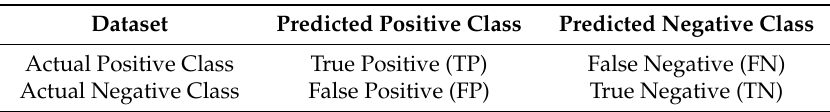
Table 2. Confusion